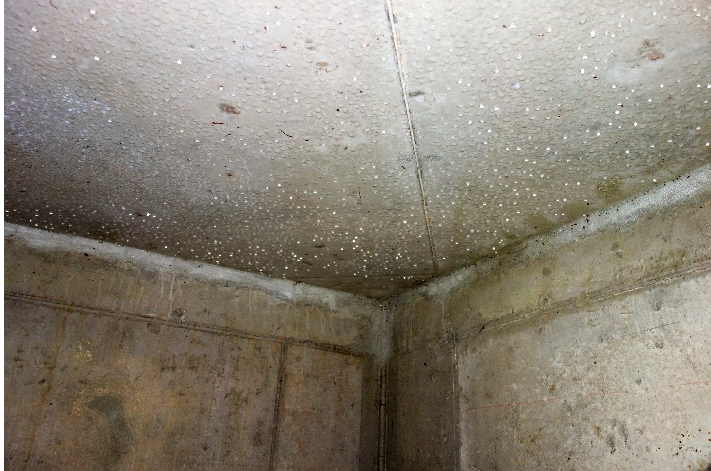
Figure 18. Condensation on the bottom side of the roof slab when the inspection pit and the connecting drainage pipes are operational.